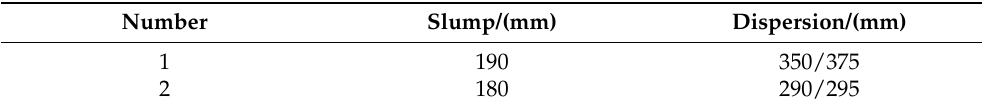
Table 3. Slump test results.